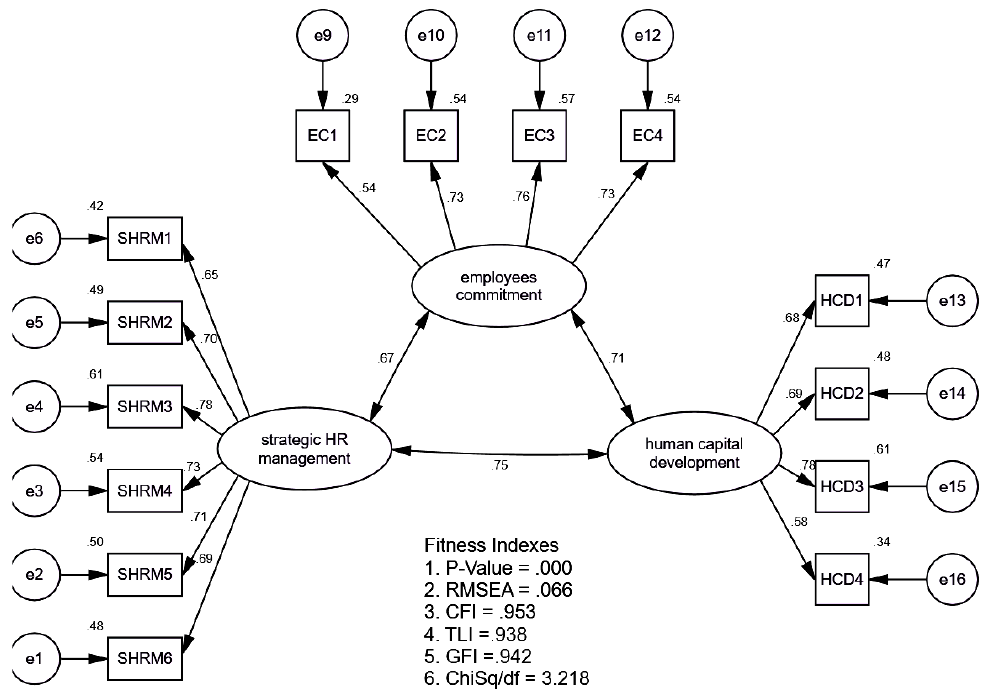
Figure 2. The measurement model of all